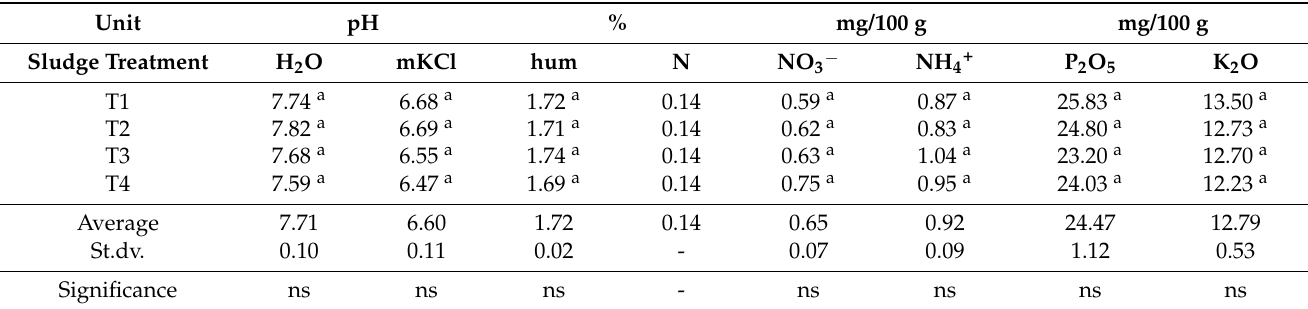
Table 3. Basic soil chemical properties after application of different amounts of sewage sludge and cultivation with Virginia mallow.